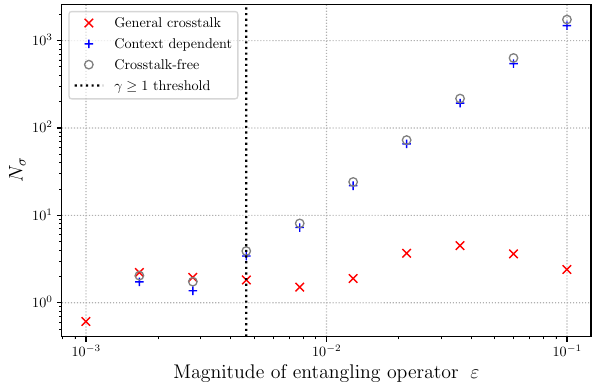
FIG. 8. Wildcard error for entangling-error-free models in the presence of entangling error (simulation). Here we show the wildcard error assigned to fits of the context-dependent and crosstalk-free models when an entangling error is present. For ε ≤ ε ∗ = 4.6 × 10 − 3 , the wildcard error budget for all three models is zero. However, for ε > 4.6 × 10 − 3 , the wildcard error for the context-dependent and crosstalk-free models increase approximately linearly with ε in the regime shown. The wild- card error for the general crosstalk model is zero for all values of ε , as this model always properly fits the